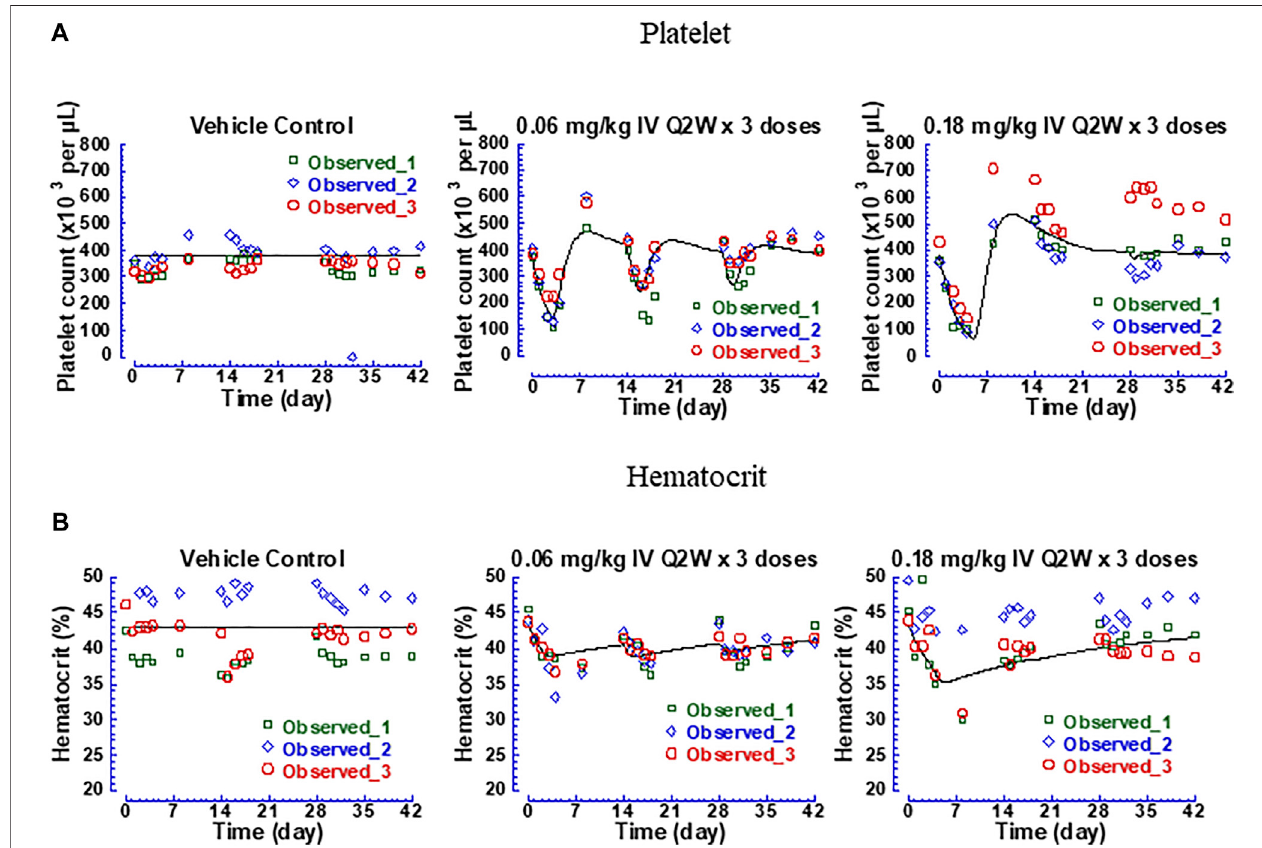
FIGURE 6 | Fitted versus observed platelet count and hematocrit data of hFc-hIL-10 in cynomolgus monkeys after repeat intravenous doses of 0.06 and 0.18 mg/kg given once every 2 weeks for 3 doses. (A) Platelet counts; (B) Hematocrit. Lines represent the model- fi tted curves; symbols show individual observed data (n = 3 per time point).